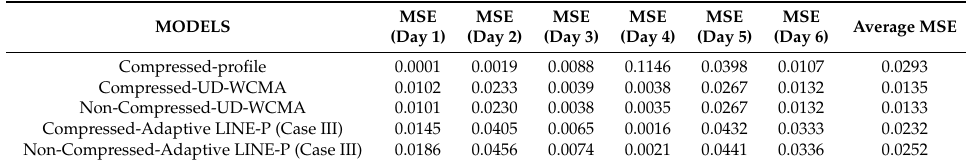
Table 19. Error estimation in terms of MSE of the prediction models with and without the compressed profile method for the wind energy